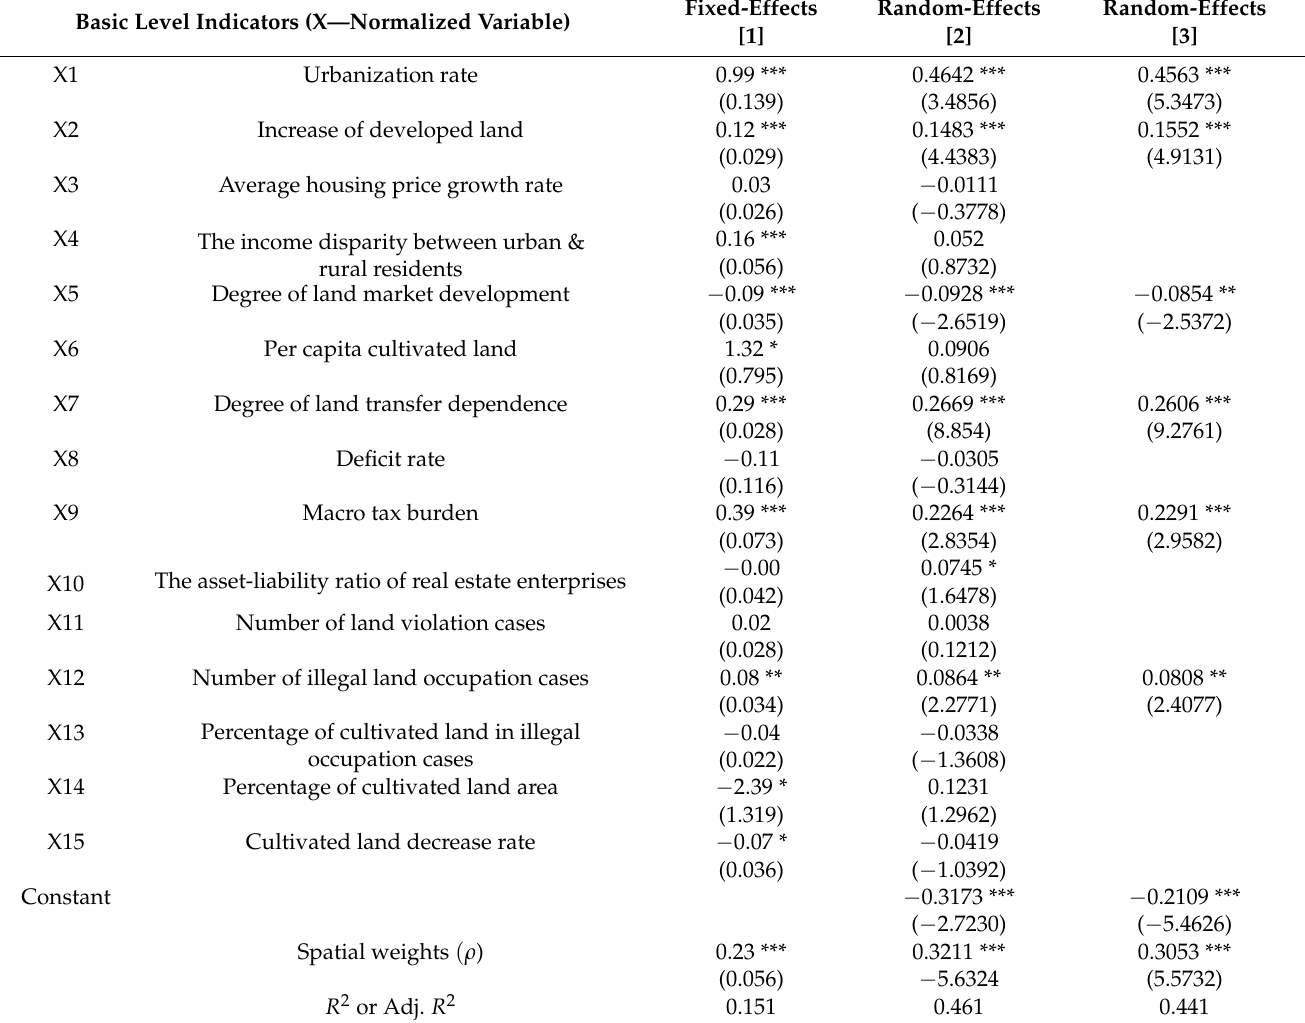
Table 5. The parameter estimates of risk factors of land finance at the national